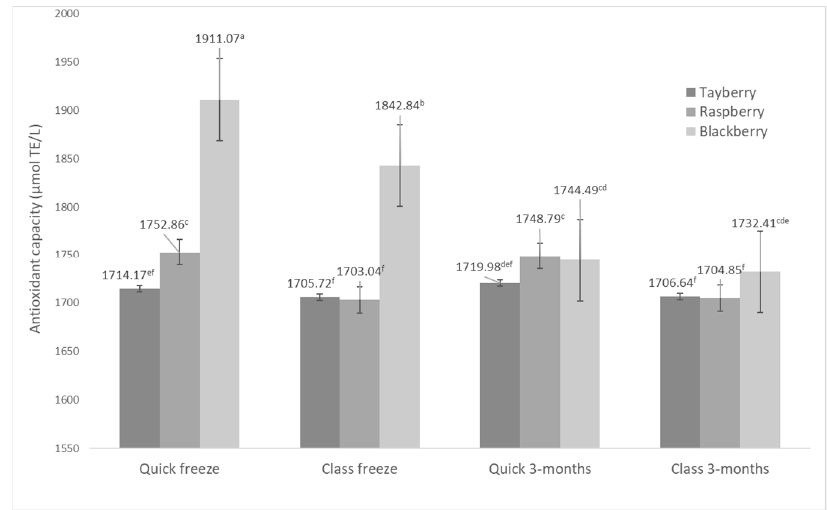
Figure 3. Antioxidant capacity (µmol TE/L) of frozen berry fruits and after storage, depending on the freezing method. Different letters indicate significant differences between mean values at p ≤ 0.0001. Significance of interaction: V × F–variety and freezing method p ≤ 0.7530; V × S–variety and storage p ≤ 0.0001; F × S–freezing method and storage p ≤ 0.8837; V × F × S–variety, freezing method